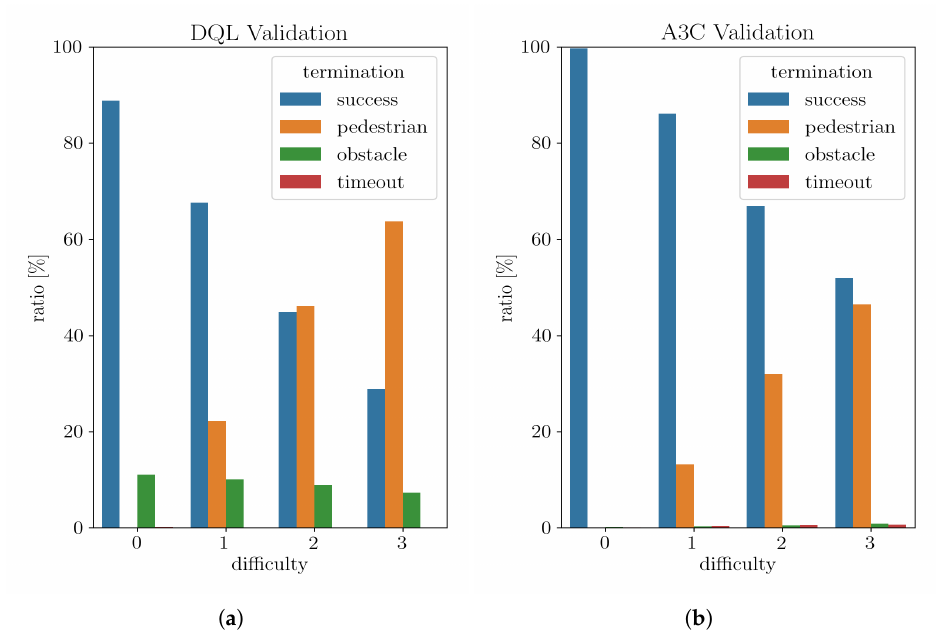
Figure 14. Barplots indicating the performances of the trained NNs and obtained with the validation process: in ( a ) the bar plots showing the success, pedestrian collision, obstacle collision, and timeout ratios, respectively, for the DQL trained NN; in ( b ) the bar plots showing the same but for the case of the A3C trained NN. Table 4. Summary of the results for the validation campaign conducted over the two trained NNs Success [%] Pedestrian [%] Obstacle [%] Timeout [%] Difficulty DQL